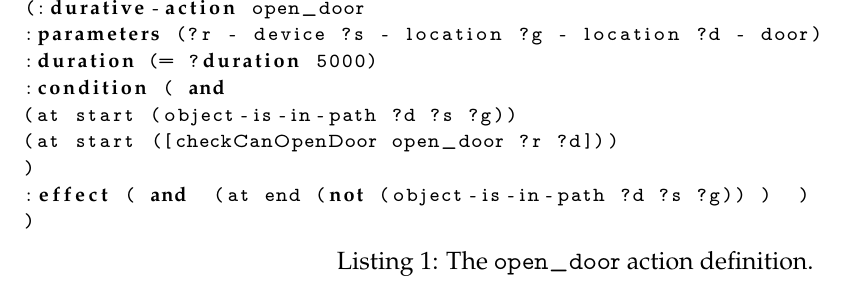
Table 1. Description of the different State